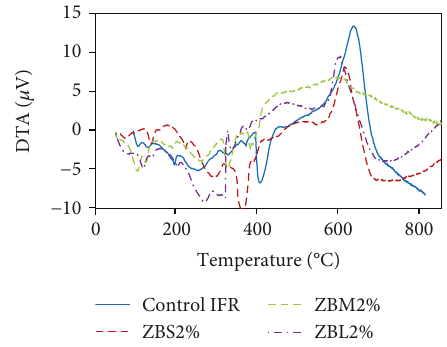
Figure 15: DTA curves of IFR/ZB coatings (under